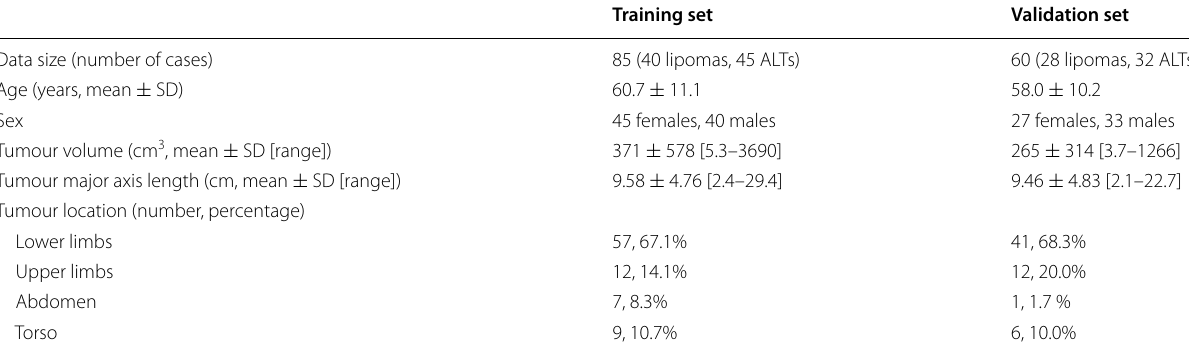
ALTs atypical lipomatous tumours, Range minimum